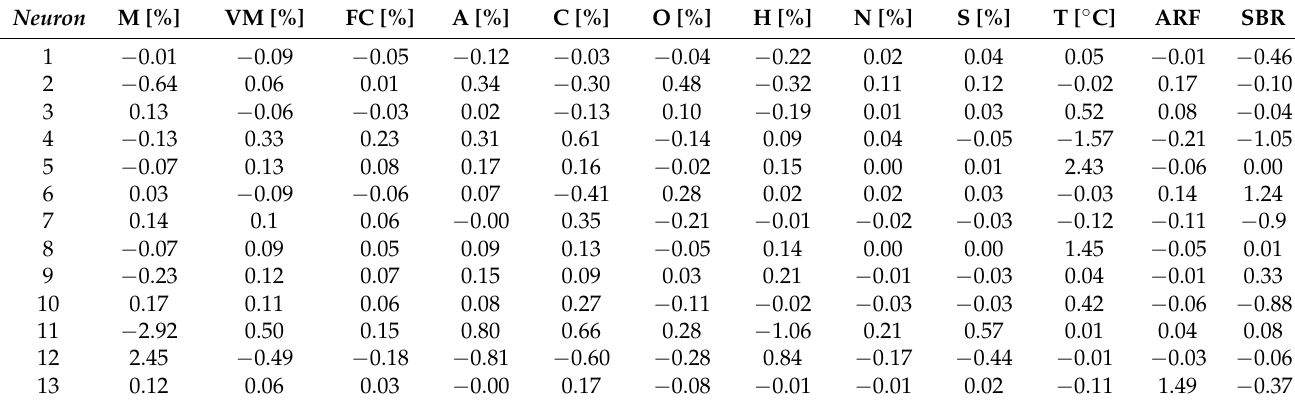
Table 3. The weights of inputs to the ANN model for prediction of sm hydrogen .